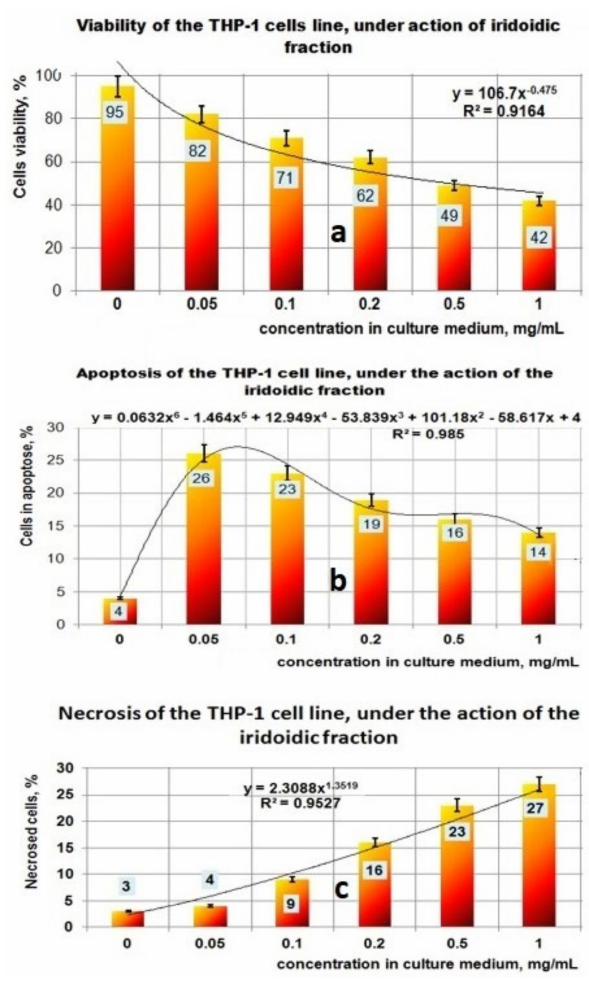
Figure 7. Effect of exposure at PI fraction on THP–1 cell lines. ( a ) Viability of THP–1 cell line under action of PI fraction; ( b ) Apoptosis of THP–1 cell line under action of PI fraction; ( c ) Necrosis of THP–1 cell line under action of PI